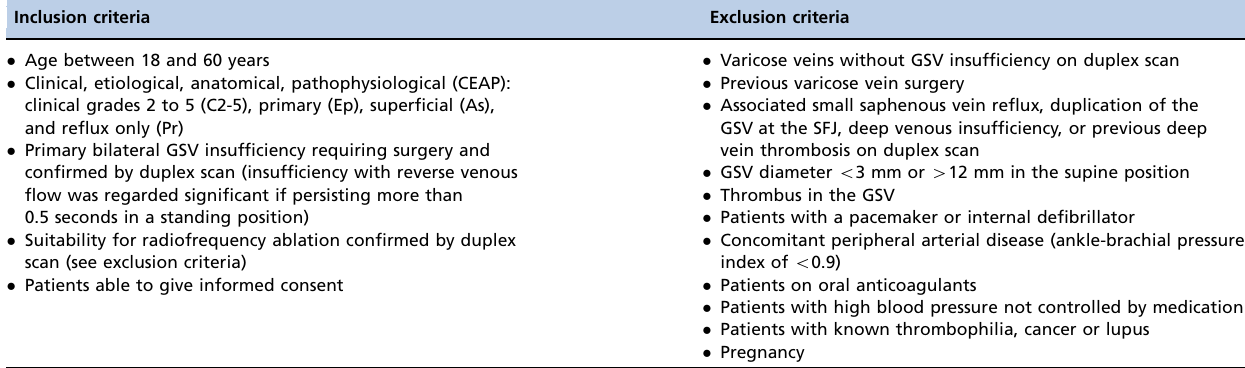
Table 1 - Inclusion and exclusion